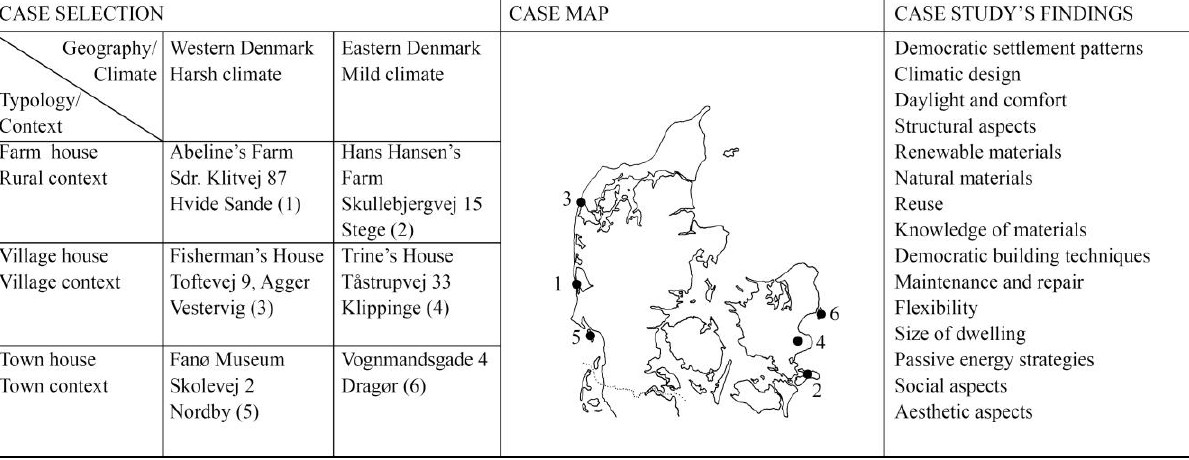
Figure 1. Left: Case selection criteria for the multiple case study of the PhD thesis. The three propositions geography, typology and context aimed to ensure heterogeneity and to secure a theoretical satisfactory dispersion among the six cases. Middle: Map of Denmark showing the positions of the cases. Right: The generated sustainable aspects of the case studies (Diagram by the